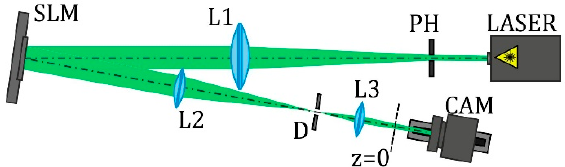
Figure 1. Experimental setup for the investigation of the generation and propagation of designed autofocusing optical vortex (OV) beams: PH, pinhole (aperture size of 40 μ m); L1, L2, and L3 are lenses ( f 1 = 350, f 2 = 350, and f 3 = 150 mm, respectively); SLM, spatial light modulator (HOLOEYE, PLUTO VIS with a 1920 × 1080 pixel resolution); D, circular aperture; and CAM, video camera.